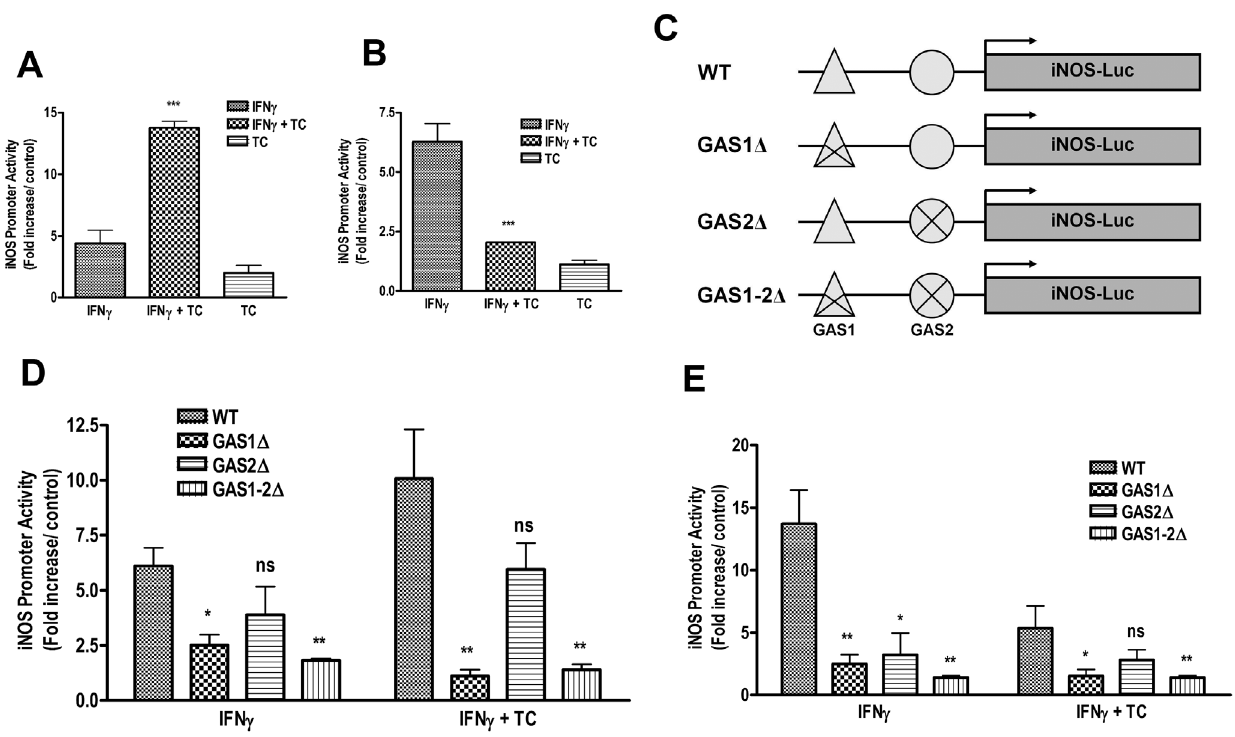
Figure 6. T.congolense and IFN- c -induced iNOS promoter activity is regulated by GAS1 in ANA-1, and GAS1 and GAS2 transcription factors in BALB.BM. Serum-deprived macrophage cell lines ANA-1 (A, D) and BALB.BM (B, E) were transiently transfected with wild-type (WT) luciferase construct harboring iNOS promoter sequence. Transfected cells were stimulated with T. congolense WCE, IFN- c or both to assess iNOS promoter activity (A, B). Additionally, cells were transfected with constructs containing WT or mutated at GAS1, GAS2, or both (D, E); a schematic of mutants is shown in C. Cells were then stimulated with IFN- c , TC or both; and iNOS promoter luciferase activity was measured by dual-luciferase assay kit (Promega). Data represent fold increase in (Renilla) normalized iNOS promoter activity compared to unstimulated control and are representative of 3 different experiments with similar findings. *, p , 0.05; **, p , 0.01; ***, p , 0.001 compared to IFN- c -stimulated control (A, B), or WT stimulated control (D, E). ns, not